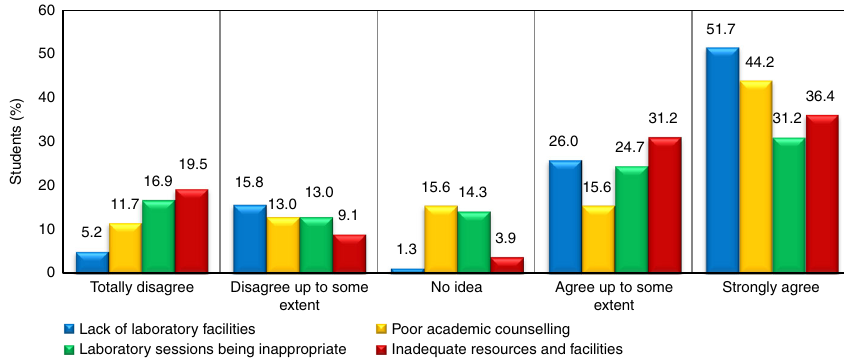
Figure 2. Institutional barriers rated as significant for on-time completion of the degree